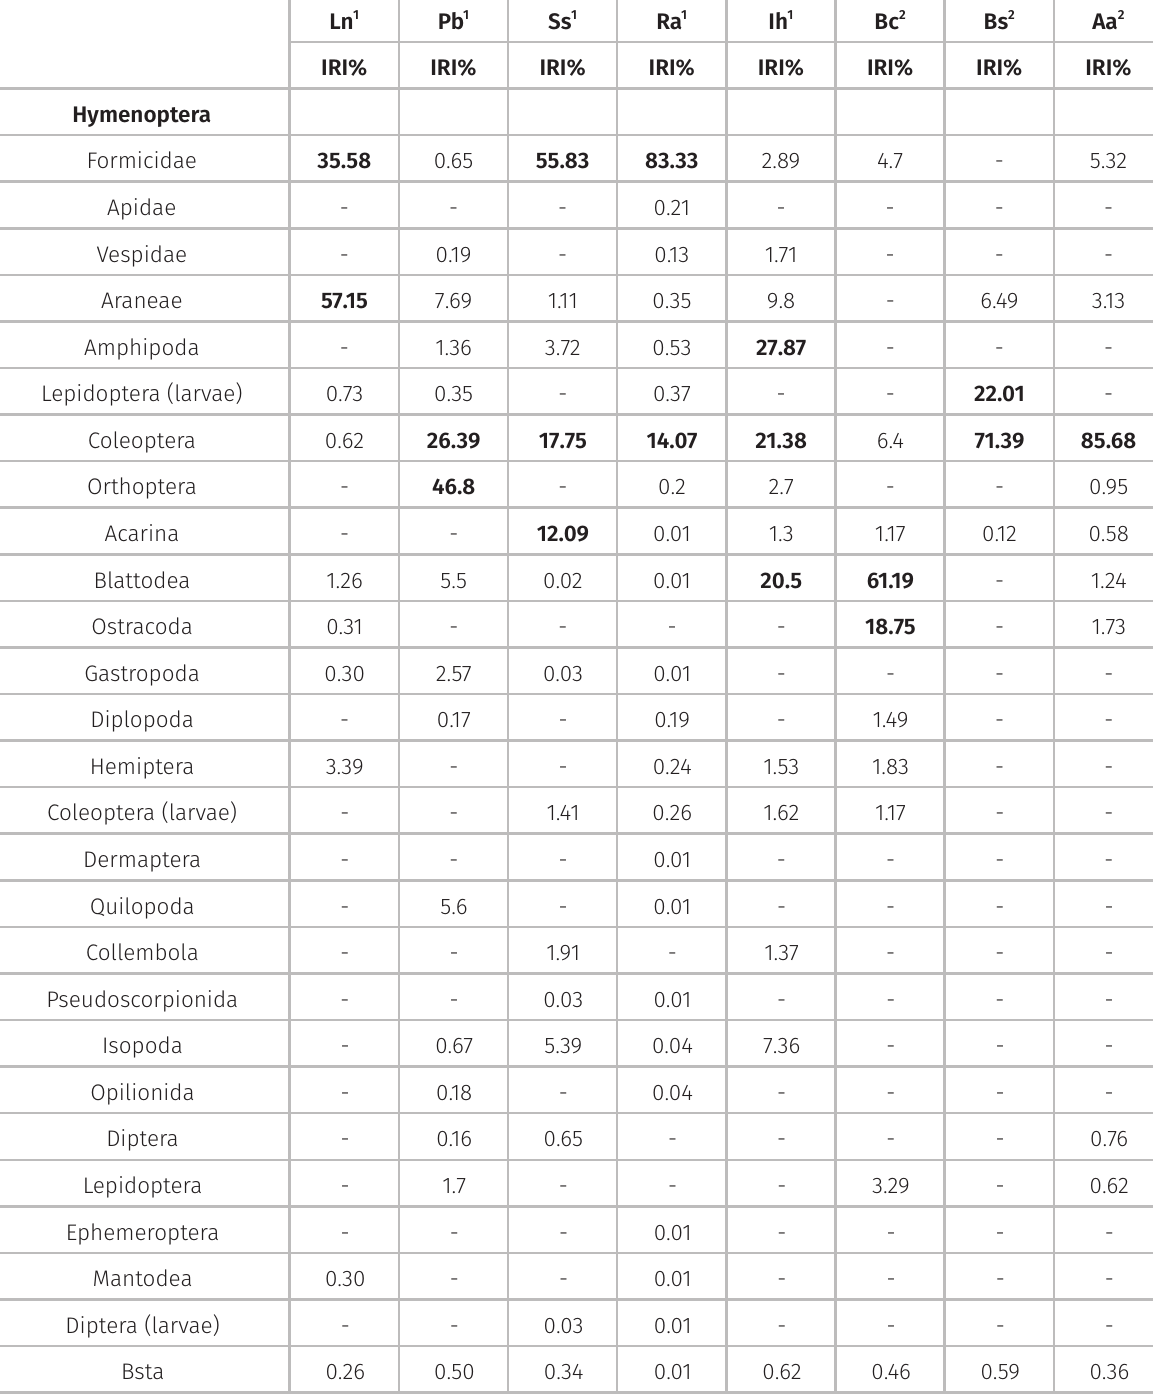
Table I. Prey categories found in the gastrointestinal content of the species evaluated. Legenda: Ln = Leptodactylus notoaktites , Pb = Proceratophrys boiei , Ss = Scythrophrys sawayae , Ra = Rhinella abei , Ih = Ischnocnema henselii , Bc = Bokermannohyla circumdata , Bs = Boana semiguttata , Aa = Aplastodiscus albosignatus , IRI% = Index of Relative Importance, Bsta = trophic niche breadth. Red numbers indicate high IRI values. 1 species of terrestrial habit; 2 species of tree